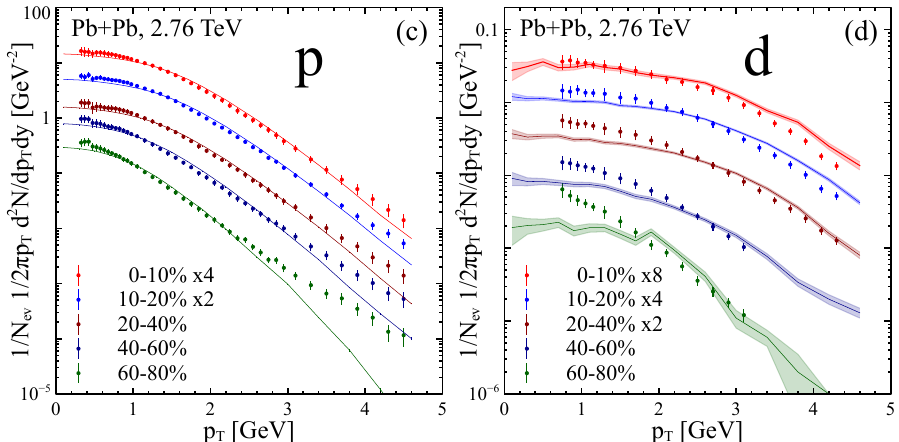
Figure 2. Centrality-dependent p T -spectra of identified particles(( a )—pions, ( b )—kaons, ( c )—protons, √ s NN = 2.76 TeV. Measurements by ALICE collaboration [1,11] ( d )—deuterons) in Pb+Pb collisions at (circles) are compared to our hybrid (hydrodynamics + transport) approach calculation (lines). Note that computing deuteron spectra is parameter-free and does not apply coalescence model (see